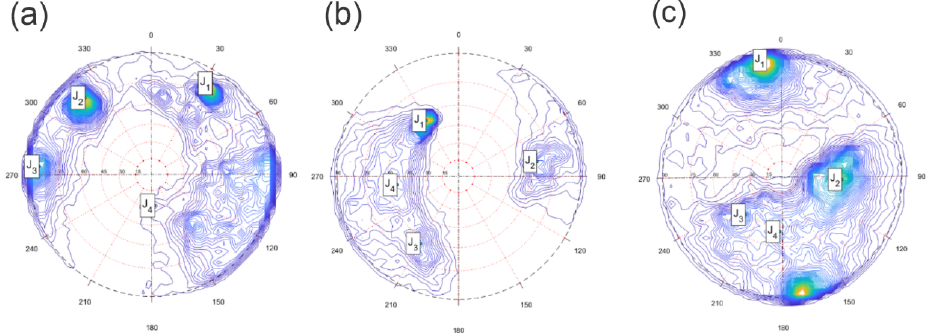
Figure 4. Stereonets with the four main discontinuity sets (J1–J4) classified using DSE software (Riquelme et al., 2014). The density of the principal poles corresponds to the main discontinuity sets identified from the point clouds. (a) Pastýˇrská rock, (b) Branická rock, (c) Tašovice.